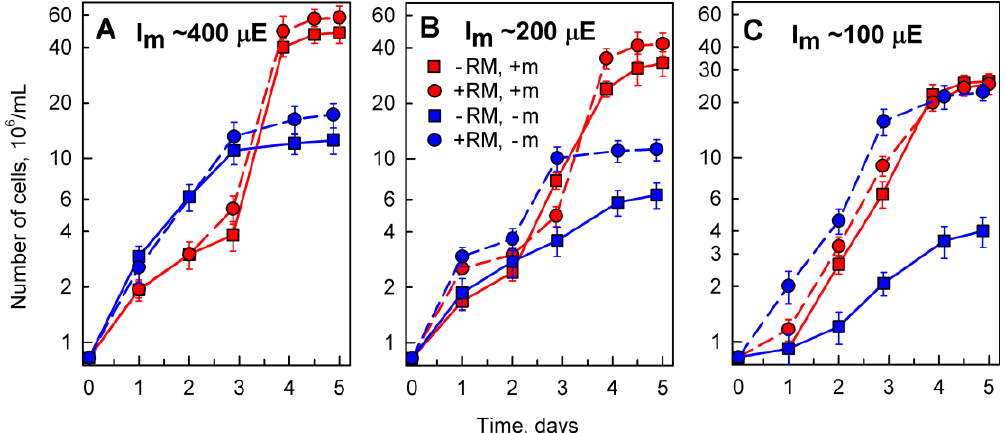
Figure 4. Changes in number of Desmodesmus quadricauda cells grown in the absence (-RM) or presence (+RM) of different red mud concentrations in different nutrient media: 0.03% (panel A ), 0.05% (panel B ), 0.1% (panel C ). The experimental variants were grown either in complete (+m) or in incomplete nutrient media (−m) lacking added microelements. Mean light intensity (I m ) decreased due to increasing shadowing by solid particles with increasing concentration of red mud: 400 µE (panel A), 200 µE (panel B), 100 µE (panel C). Mean light intensity of the control cultures (−RM) was adjusted so it matched the mean light intensities of the corresponding red mud treated culture.